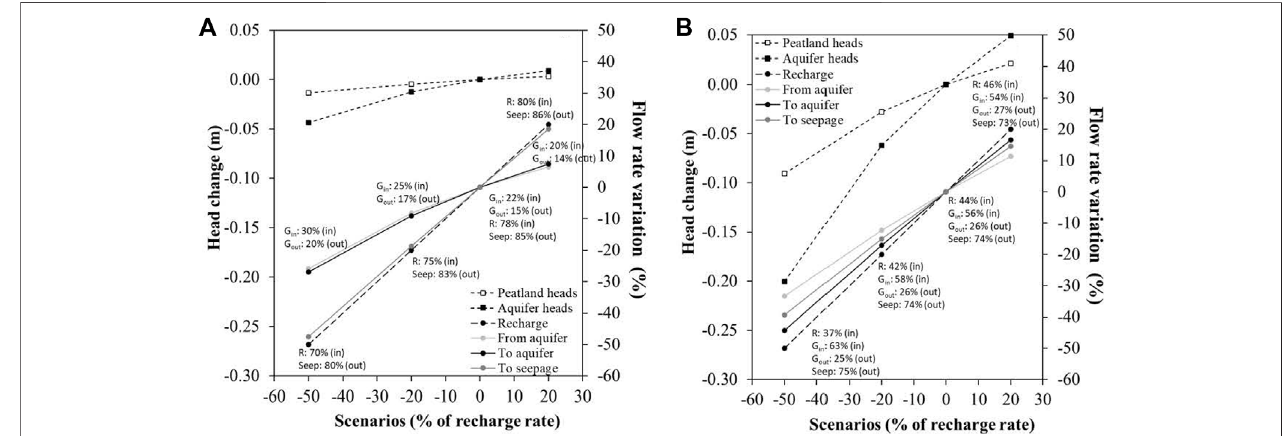
FIGURE 8 | Effect of climate change scenarios on average simulated peatland heads, mineral heads, and water budget fl ow components at (A) Misask peatland and (B) Cheinu peatland.